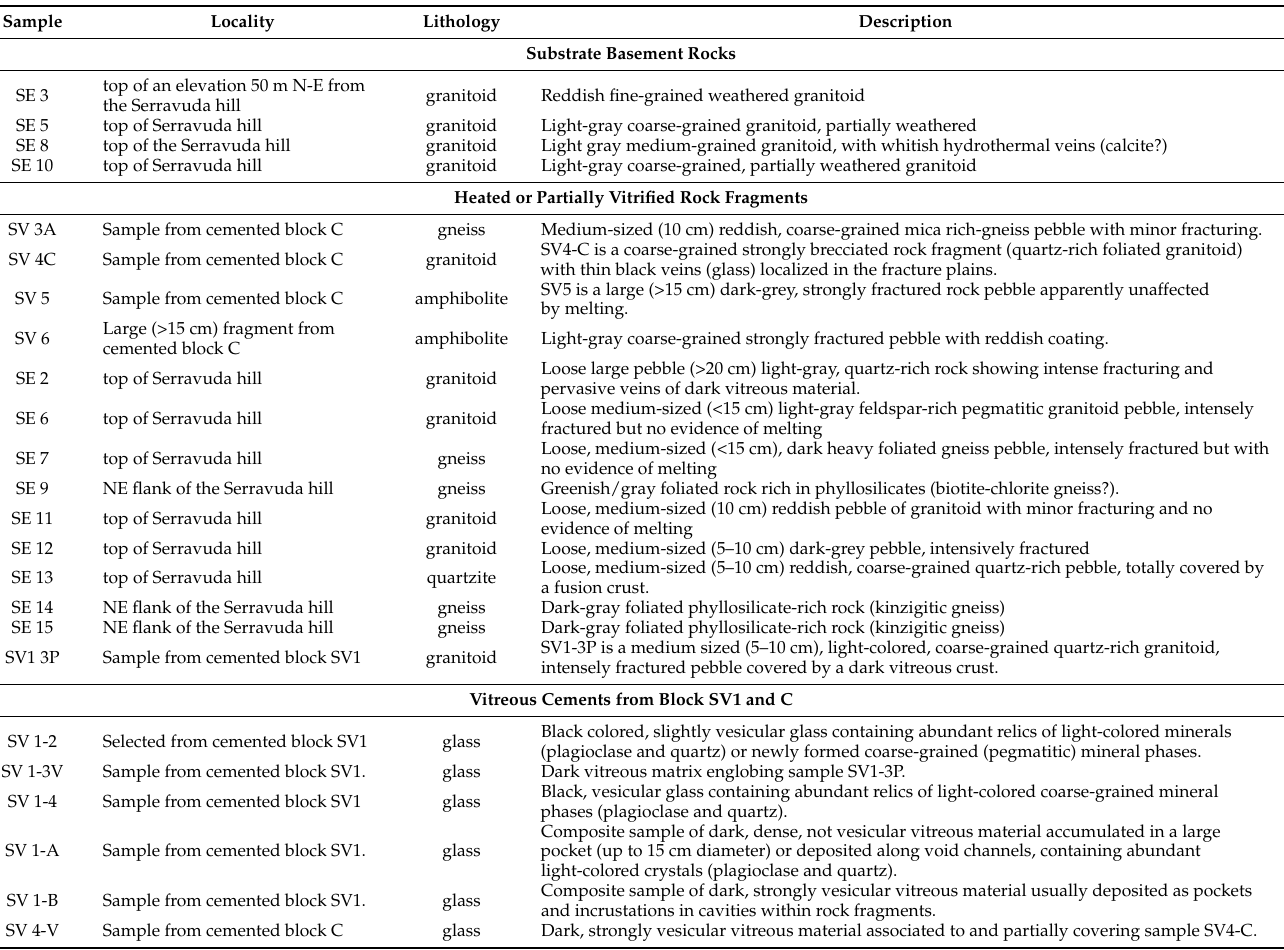
Table 1. Location, macroscopic features, and attributed lithology of the analyzed